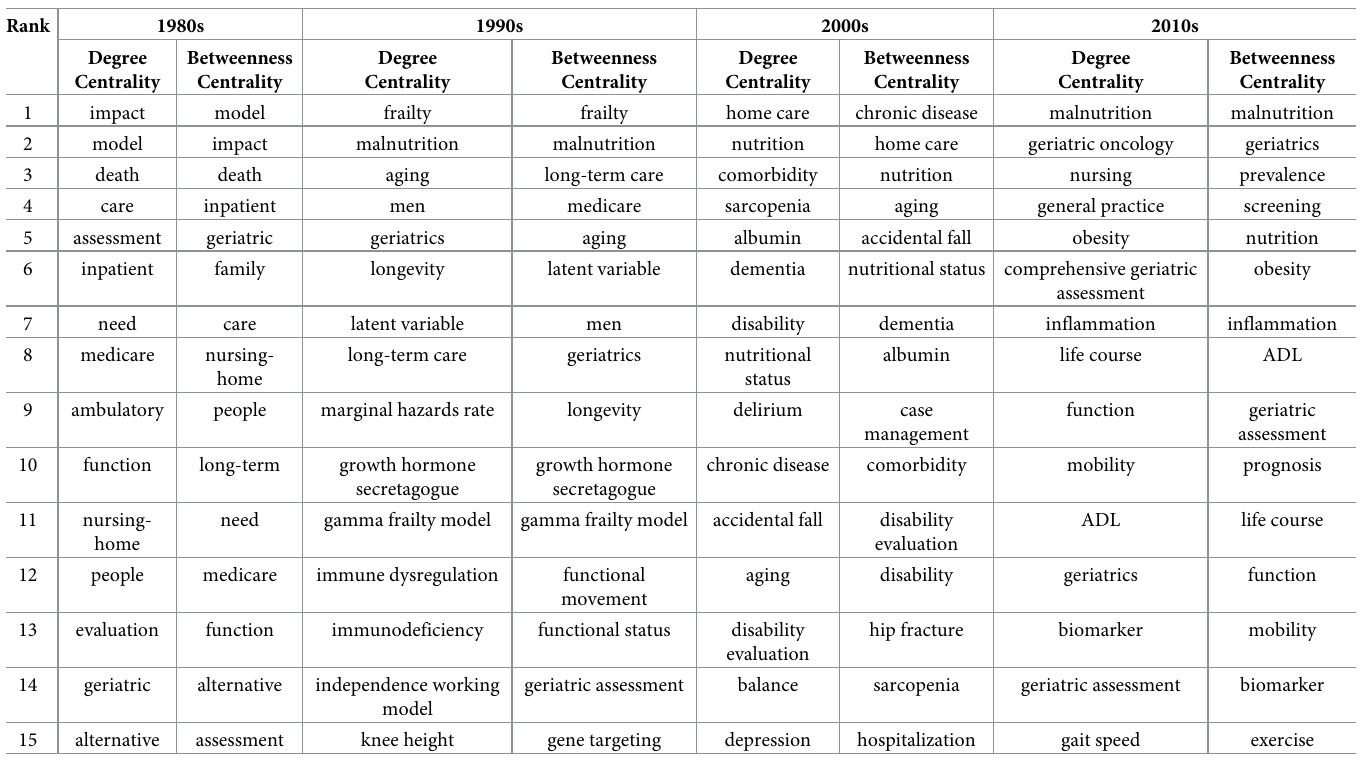
Table 1. The Top 15 keywords by centrality according to time